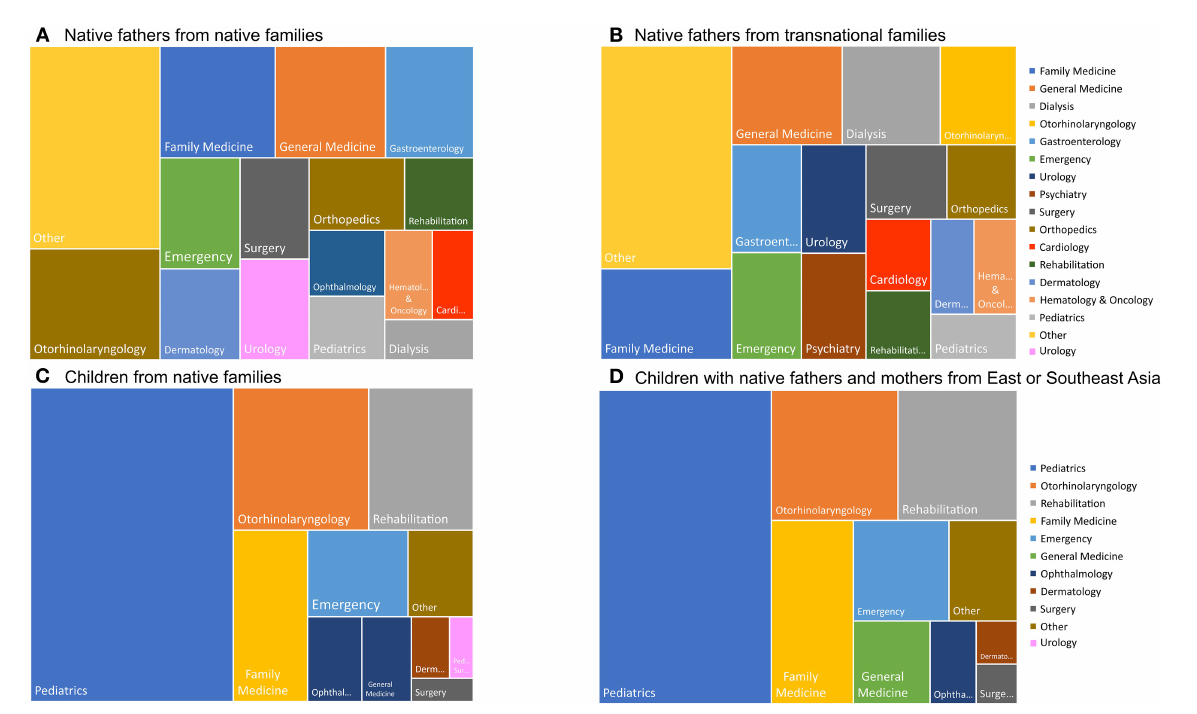
FIGURE1 The proportion of total inflation-adjusted medical cost in 2004 to 2017 for top leading medical specialties for fathers from native families (A) , native fathers from transnational families (B) , children from native families (C) , and children from transnational families (D) . Medical specialties were included if their explained proportions of the total cost reached at least